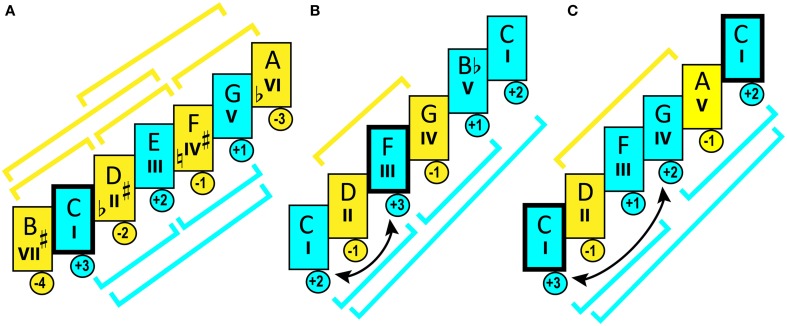
Distribution of gravity in early pentatonic and hemitonic modes. Yellow color indicates unstable, while blue—stable degrees. The intervallic distances between the degrees are reflected by vertical increments between the rectangles representing the degrees (as in an uneven staircase where some steps are taller than others). Thick rectangle marks the gravitational center. The I degree is determined by the lowest position in a base of a stable tetrachord or pentachord. (A) Heptatonic mode. Sharps and flats show strong attraction of unstable degrees to stable degrees (except the neutral IV degree). Gravity here is hierarchical: the relation of 3rds (shown by smaller brackets) is integrated into a triadic relation (as shown by larger brackets). The stable triad opposes both unstable triads. Diverse gradations in gravity (from −4 to +3) between the degrees. C is strongly marked as “tonic.” Unstable degrees have finer gradations than stable degrees, and reach high values of tension. (B) Conjunct (older) pentatonic mode. Flatness of gravitational hierarchy between the unstable degrees. F and C alternate as centers of gravity, with F prevailing. Stable 4th-chord “triad” (C-F-Bb) entraps unstable 4th dyad (D-G). Unstable degrees have low tension and no gradations. (C) Disjunct (newer) pentatonic mode. C and G alternate as centers of gravity, with C prevailing. Stable 4th–chord “triad inversion” (C-F-G) is offset by unstable 5th dyad (D-A) that has a stronger pull than the dyad in (B) because of greater harmonicity of 5th as opposed to 4th.